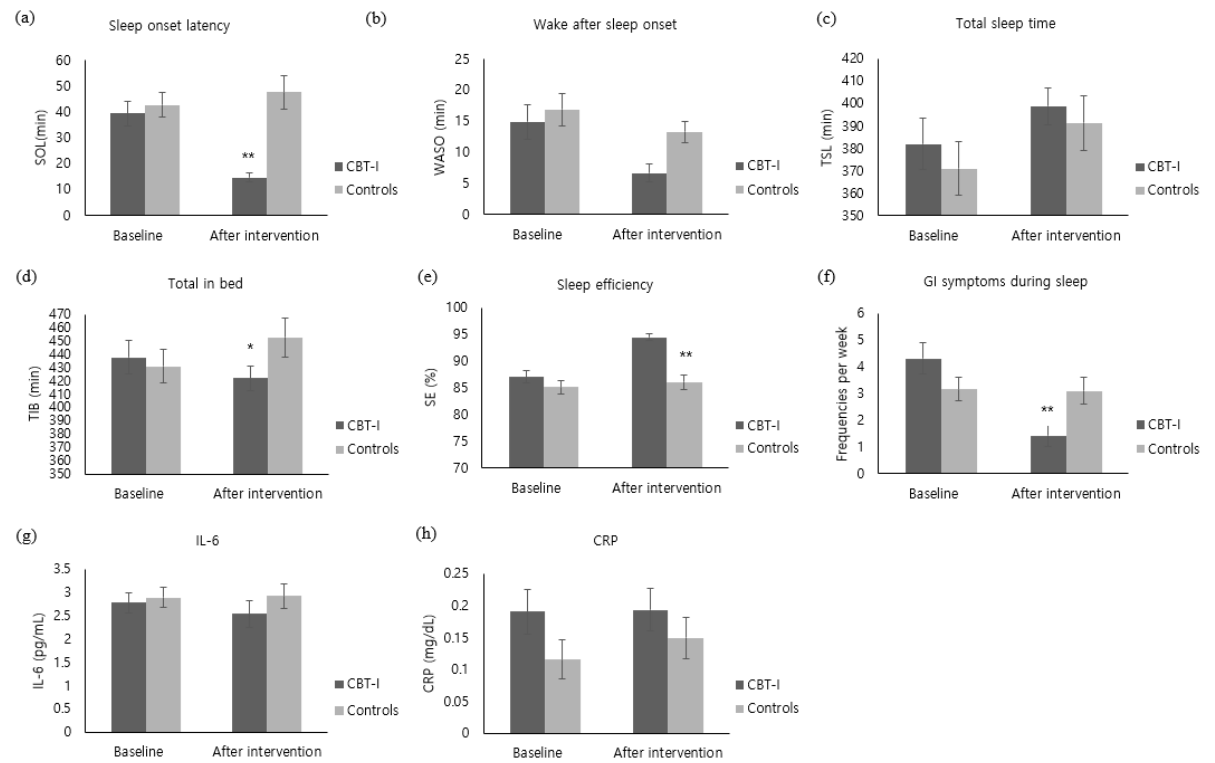
Figure 3. Comparison of outcome variables of the CBT-I and the control groups at baseline and after intervention (( a ) Sleep onset latency. ( b ) Wake after sleep onset. ( c ) Total sleep time. ( d ) Total in bed. ( e ) sleep efficiency. ( f ) GI symptoms during sleep. ( g ) IL-6. ( h ) CRP). CBI-I: Cognitive behavioral therapy for insomnia. SOL: Sleep Onset Latency. WASO: Wake Time after Sleep Onset. TST: Total Sleep Time. TIB: Total Time in Bed. SE: Sleep Efficiency. GI: Gastrointestinal. IL-6: Interleukin-6. CRP: C-Reaction Protein. * Cognitive behavioral therapy for insomnia (CBT-I) group versus control group, p < 0.05. ** Cognitive behavioral therapy for insomnia (CBT-I) group versus control group, p < 0.001.